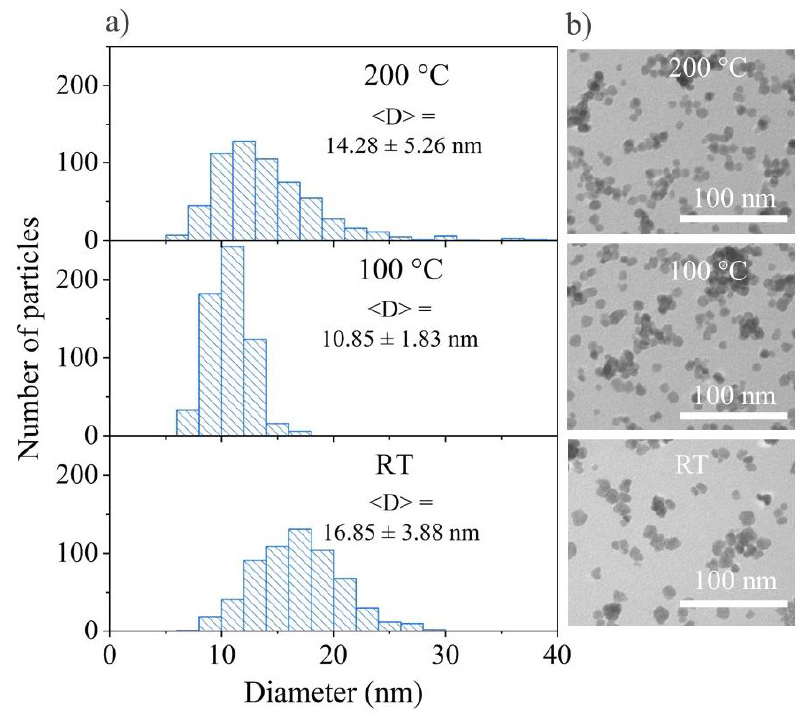
Figure 8. ( a ) Particle size distribution and <D> with the mean size ± standard deviation; ( b ) TEM images of 25Tb ST at room temperature, 100 °C, and 200 °C.